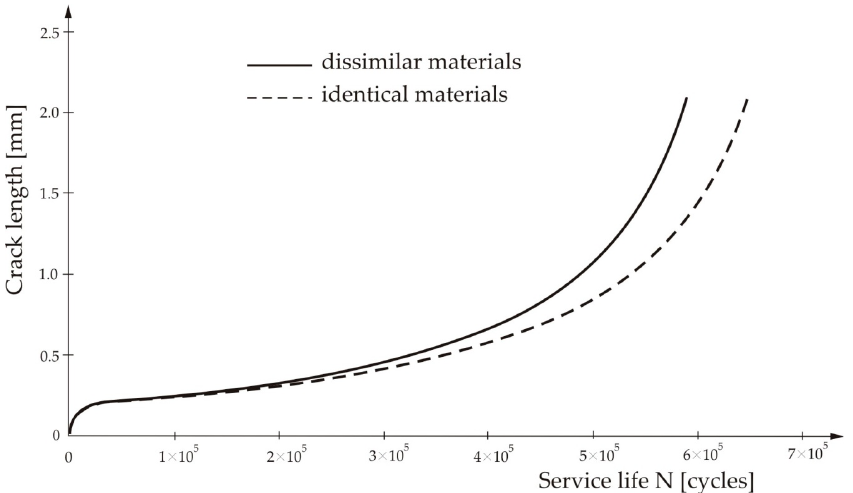
Figure 8. Number of load cycles needed for the crack propagation for the two cases of welded joints.